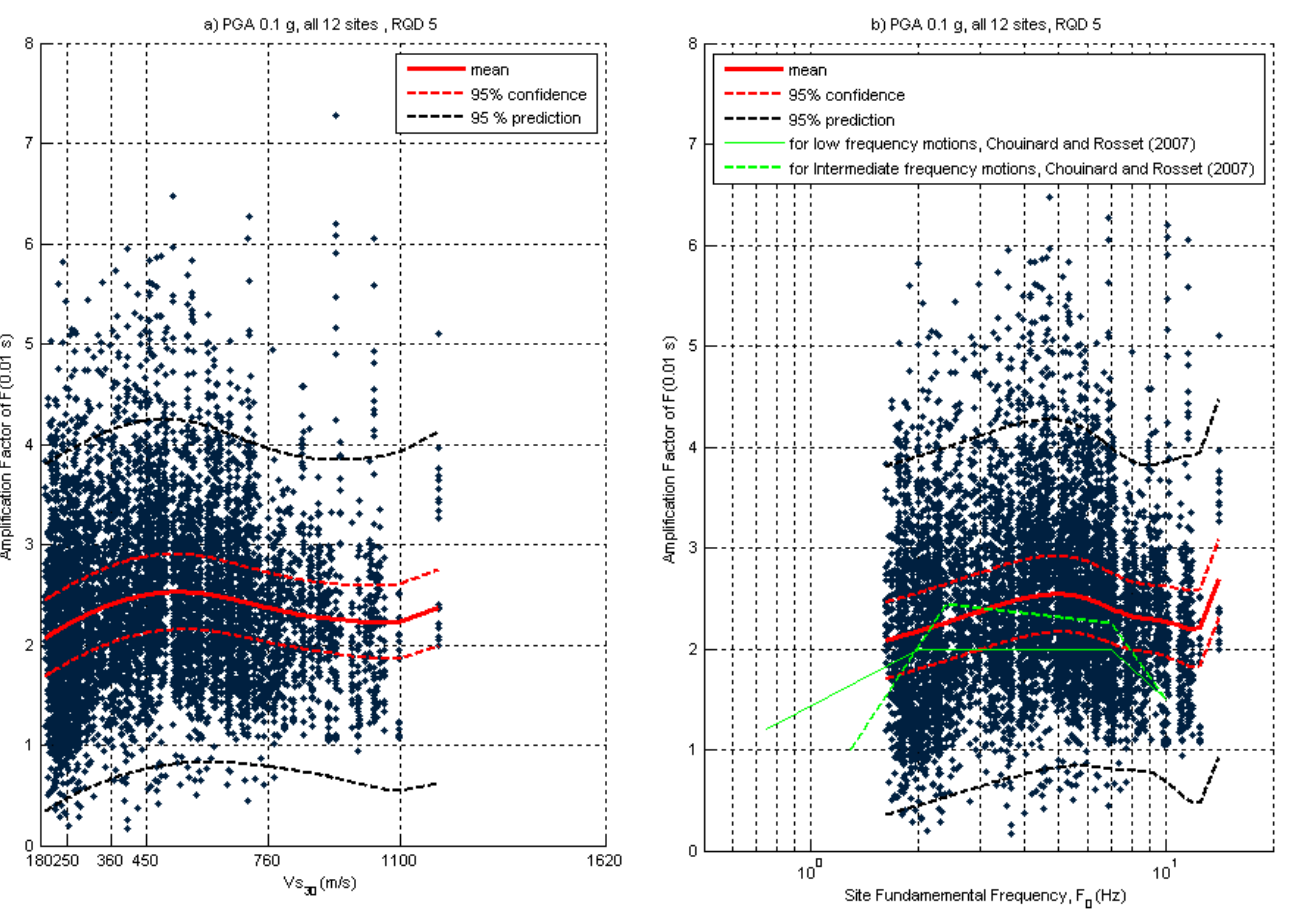
Figure 12. Amplification factors at T = 0.01 s for RQD of 5 (Vs = 2950 m/s) and PGA of 0.1 g: ( a ) as a function of Vs 30 , ( b ) as a function of site fundamental frequency F 0 .